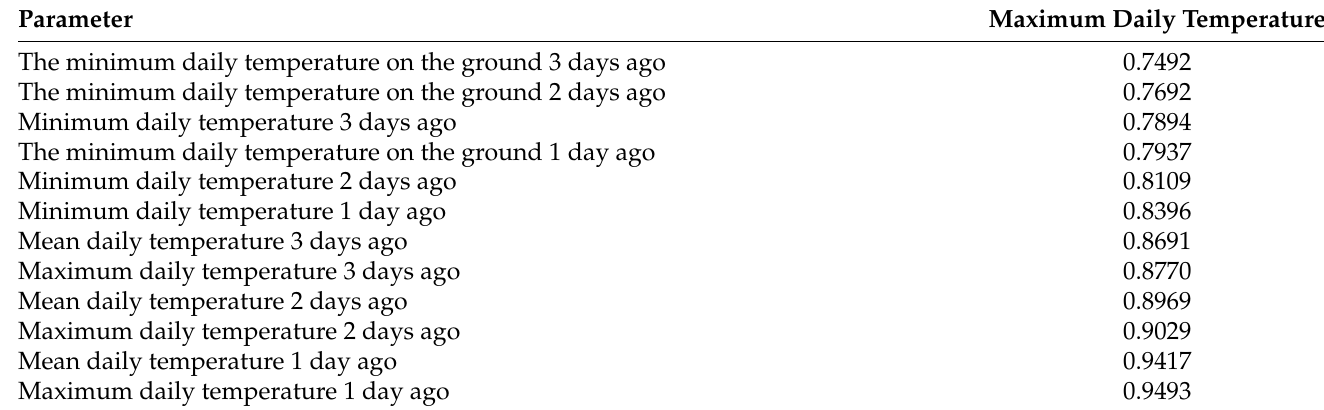
Table 15. The parameters with the strongest correlation to the predicted maximum temperature.